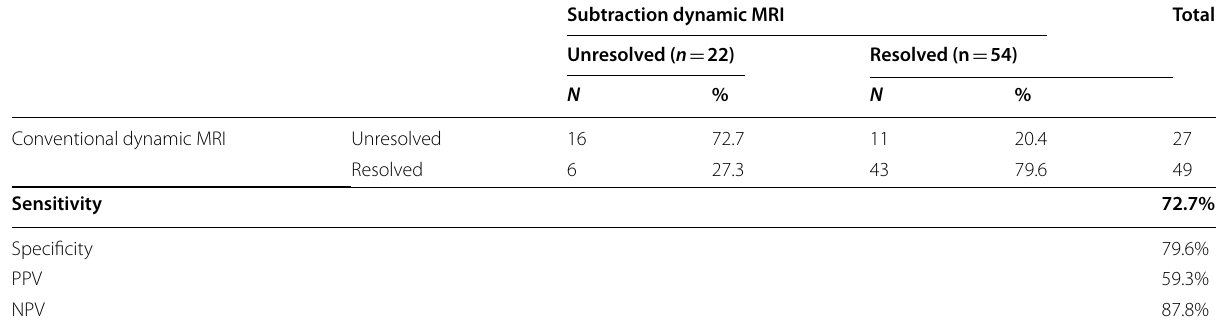
Table 2 Diagnostic indices of conventional dynamic MRI compared to added subtraction MRI as gold standard